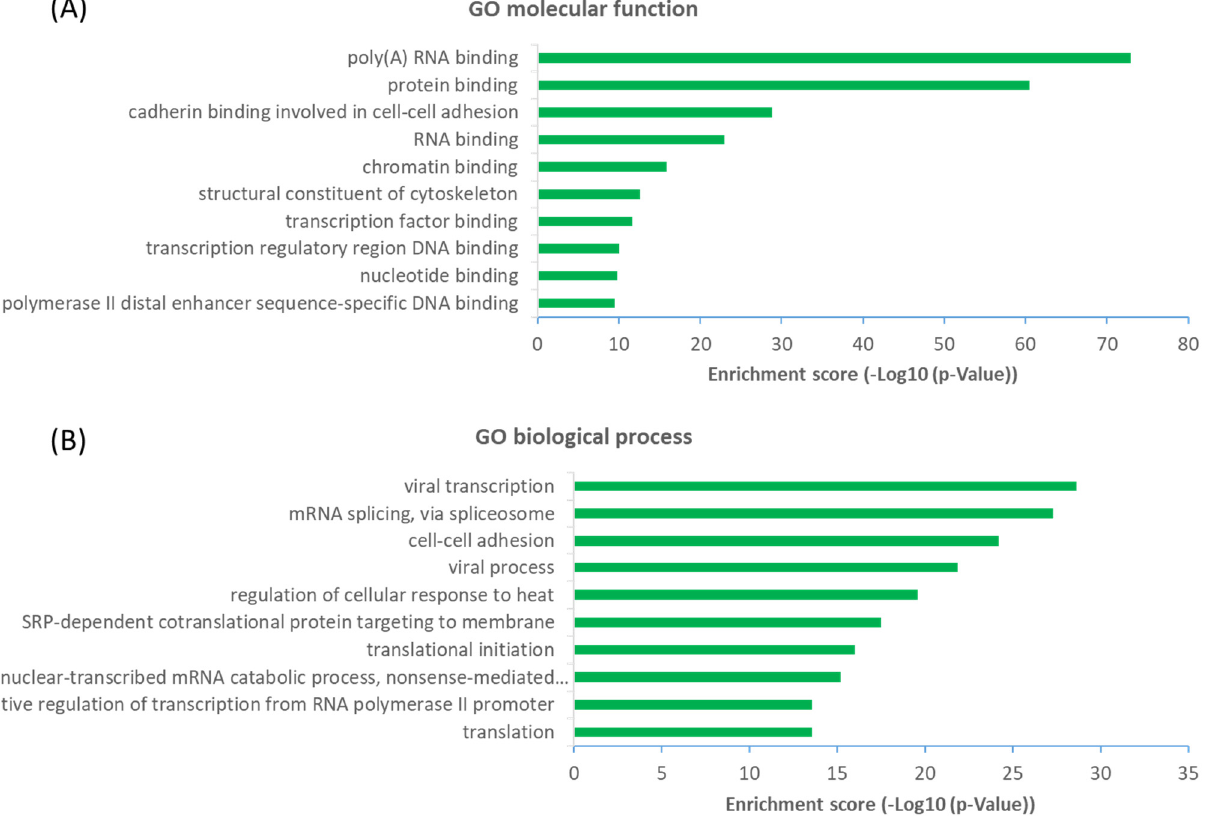
Figure 6. Functional landscape of 784 high-stringency OGT-interacting proteins in human, according to their GO molecular functions ( A ) and biological processes ( B ). Only the top ten items with the highest enrichment scores are shown.